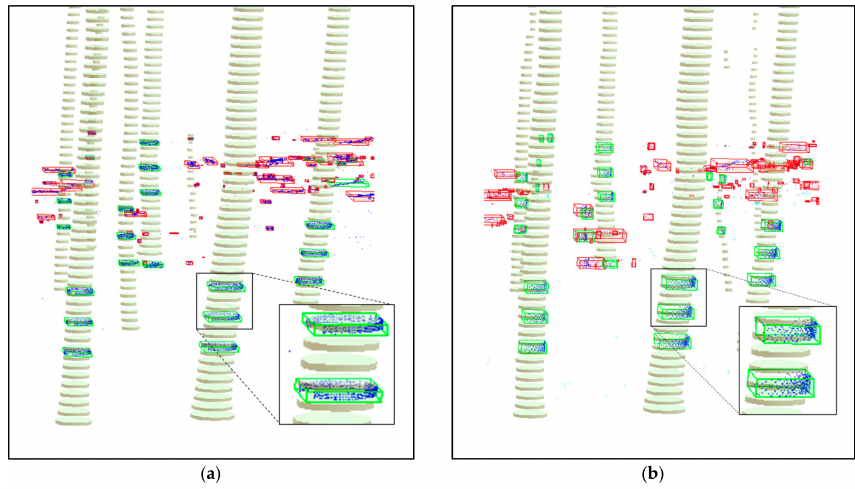
Figure 7. Three horizontal point cloud sections of the tree detection algorithm overlaid with the stem profiles of plot 1 (height interval 15 cm). Point clusters (blue points) detected as ‘tree’ are shown with a green bounding box and rejected point clusters with a red bounding box. ( a ) leaf-off TLS; ( b ) leaf-off MLS.